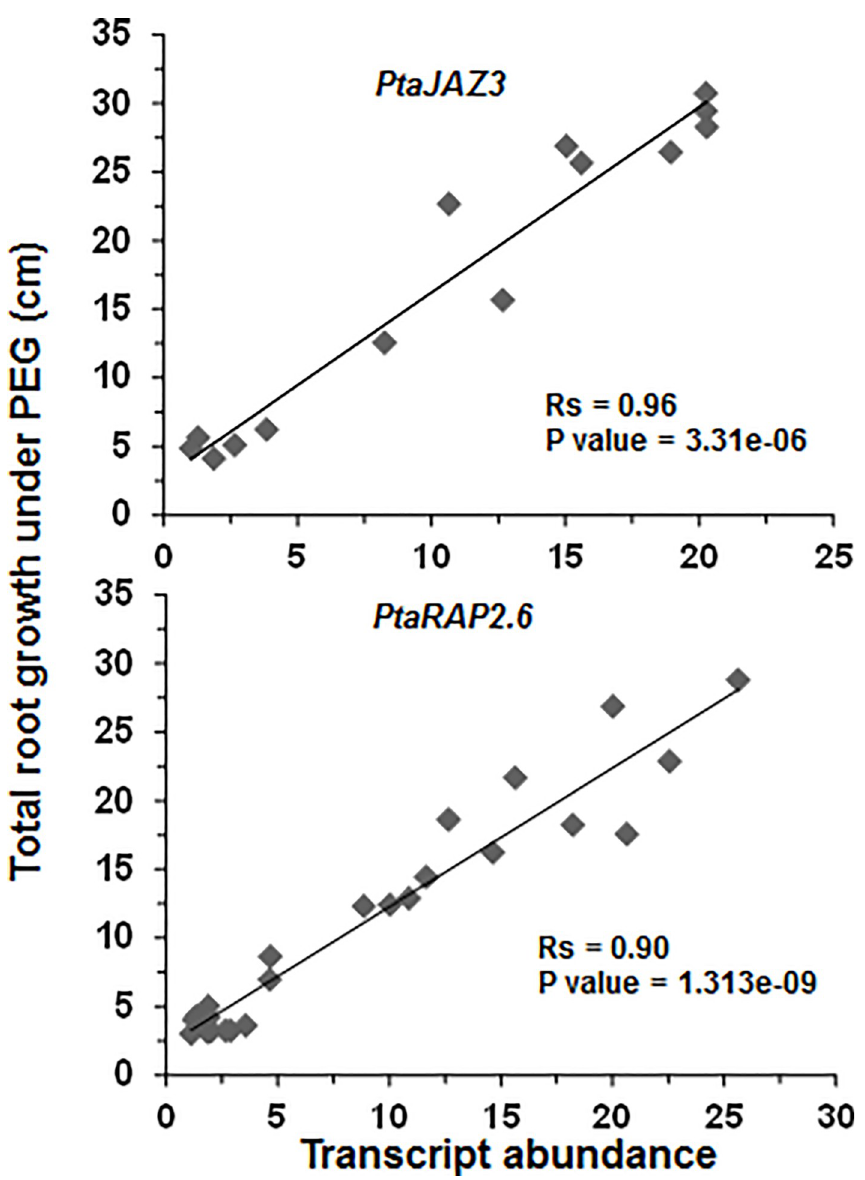
Fig 3. Level of PtaJAZ3 and PtaRAP2 . 6 transgenic overexpression is correlated to the increased root growth under PEG. Spearman rank correlation (Rs) between relative transgene expression and total root growth in PtaJAZ3 and PtaRAP2 . 6 transgenic lines. For correlation analysis, 14 and 25 independent transgenic lines were used for PtaJAZ3-oe and PtaRAP2 . 6-oe , respectively. Analysis was performed in plant roots growing in liquid media (see materials and methods for details). Total root growth represents sum of main root length and lateral root length for each plant. Transcript abundance and total root growth was analyzed in 4 replicates per transgenic line.